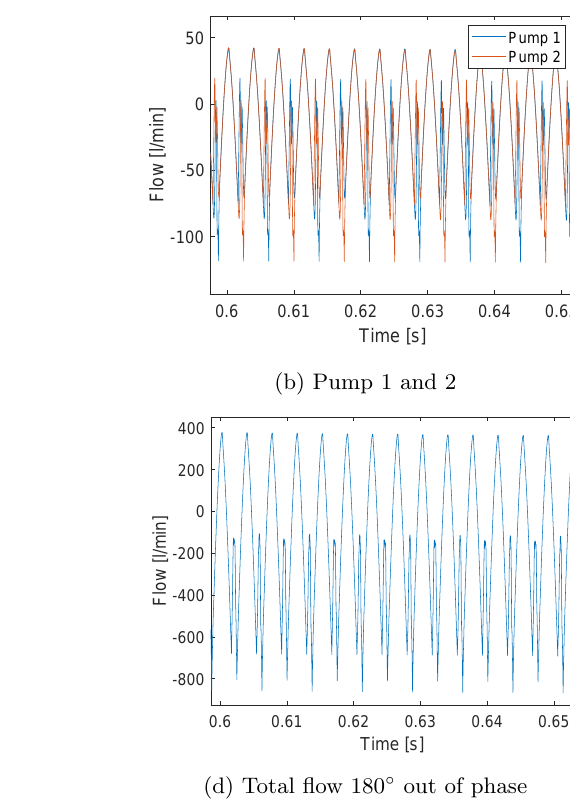
Figure 12: Flows of a (a) single pump, (b) two out of phase pumps, (c) total flow of all pumps in phase and (d) out of